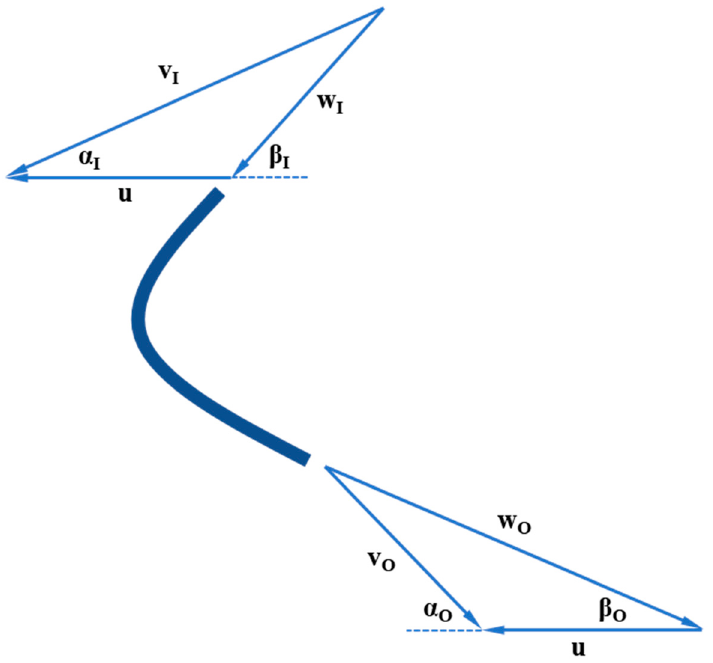
Figure 3. Diagram showing the velocity triangles at the inlet and outlet of a Turgo blade.